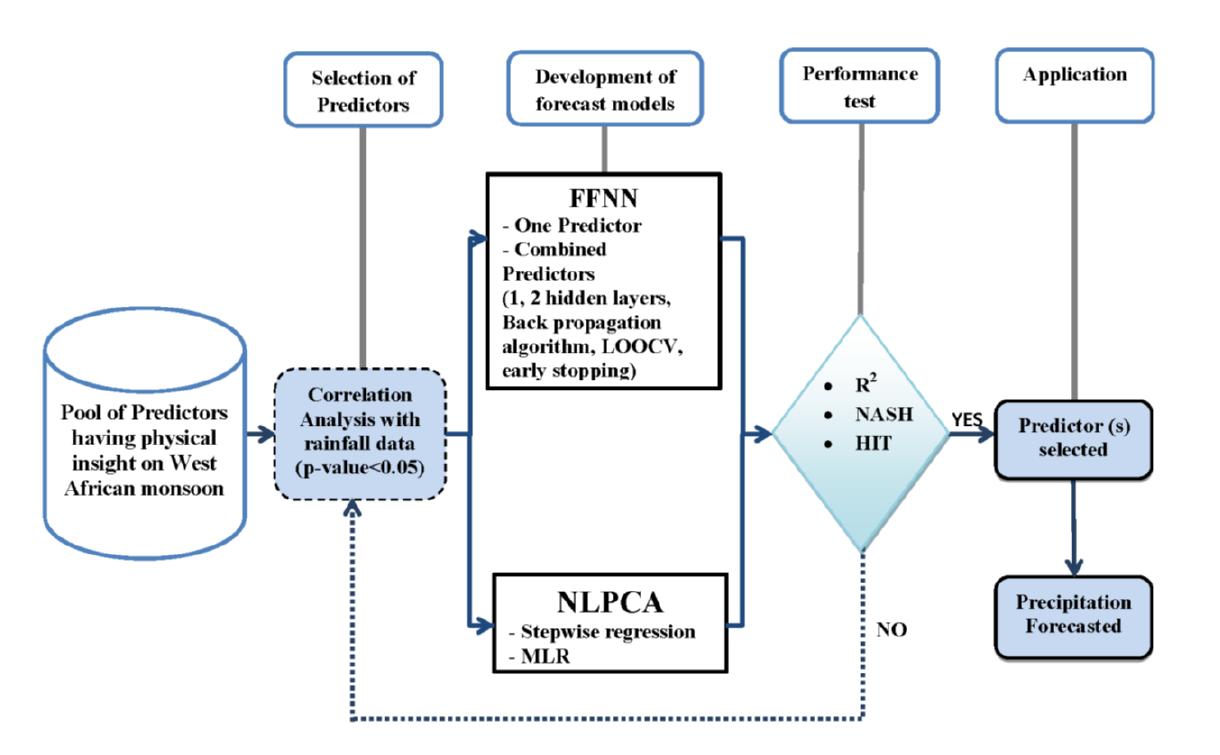
Figure 4. Developed non-linear statistical approach for rainfall